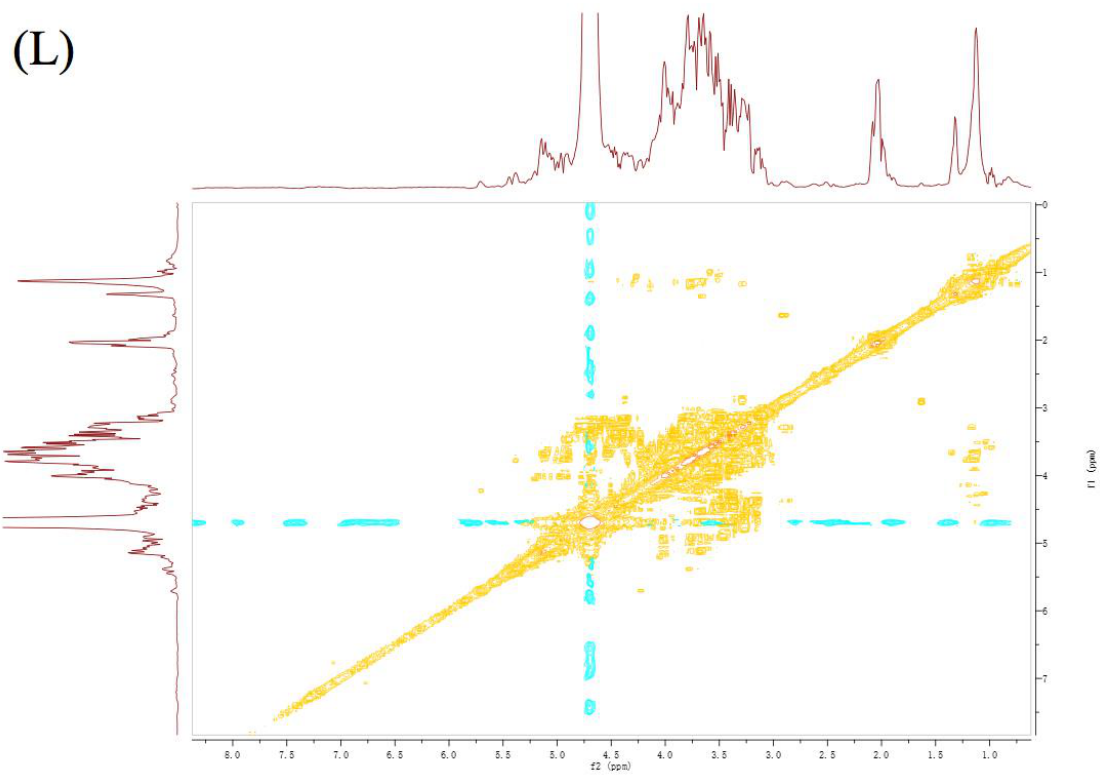
Figure 3. The NMR spectra of PFP2, PFP3, and PFP4 in D 2 O. 1 H spectra ( A – C ); 13 C spectra ( D – F ); Heteronuclear single quantum coherence (HSQC) spectra ( G – I ); 1 H- 1 H Correlation spectroscopy (COSY) spectra ( J – L ).